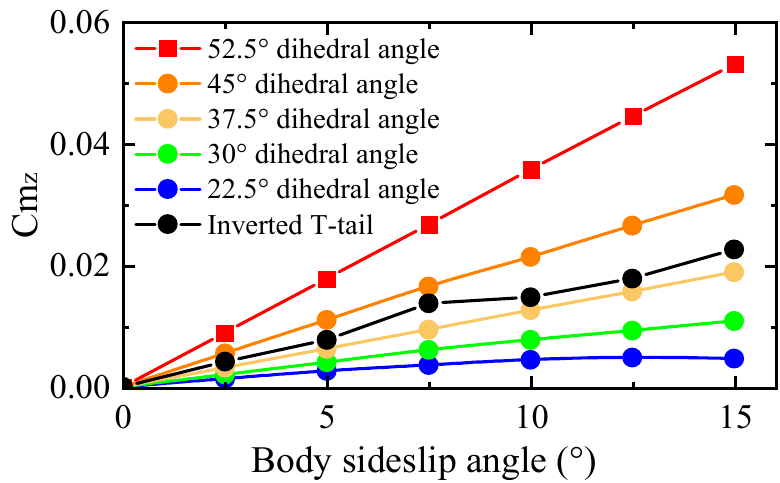
Figure 20. The relationship between the tail yaw restoring moment and body side-slip angle.